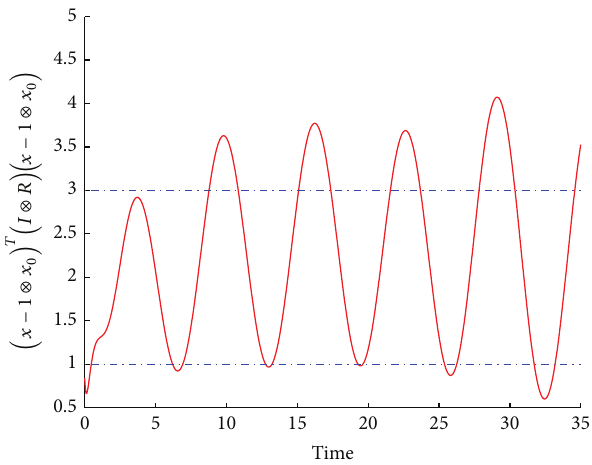
Figure 3: The error trajectories between the leader and each agent.